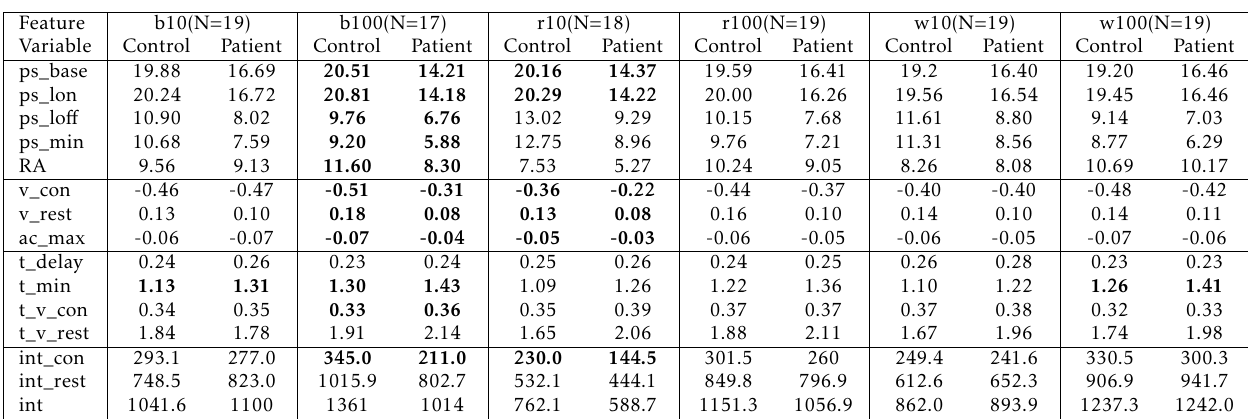
Table 3. Means of PLR features [11]